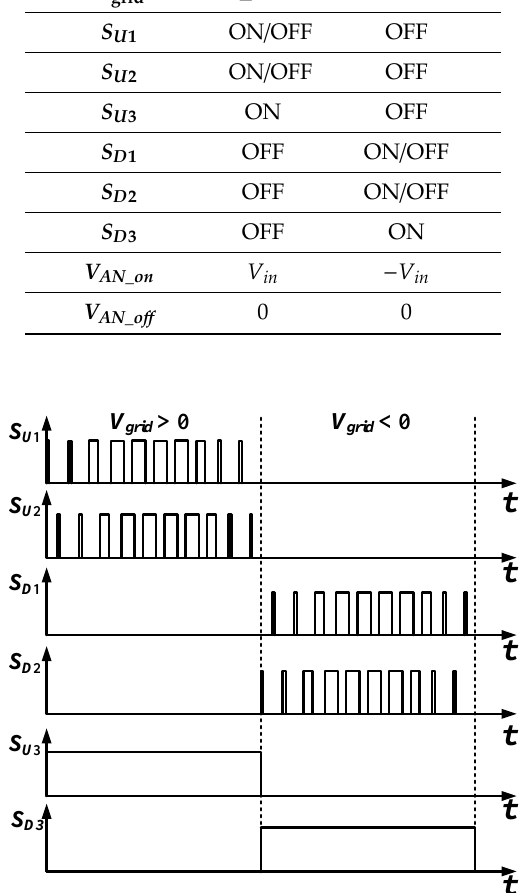
Figure 3. Simplified gate signals of the proposed inverter.